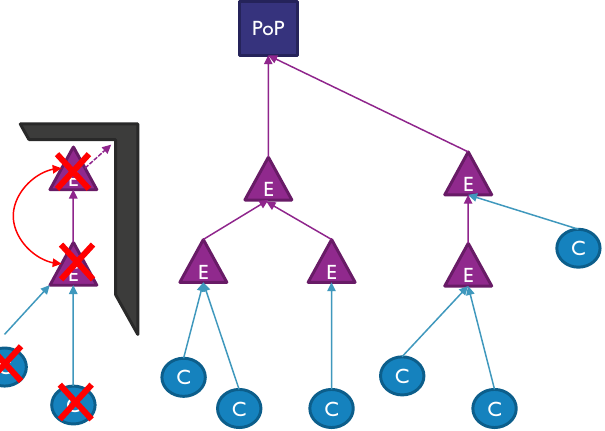
Figure 2. General tree network architecture with a example of pruning method (Section 4.1).